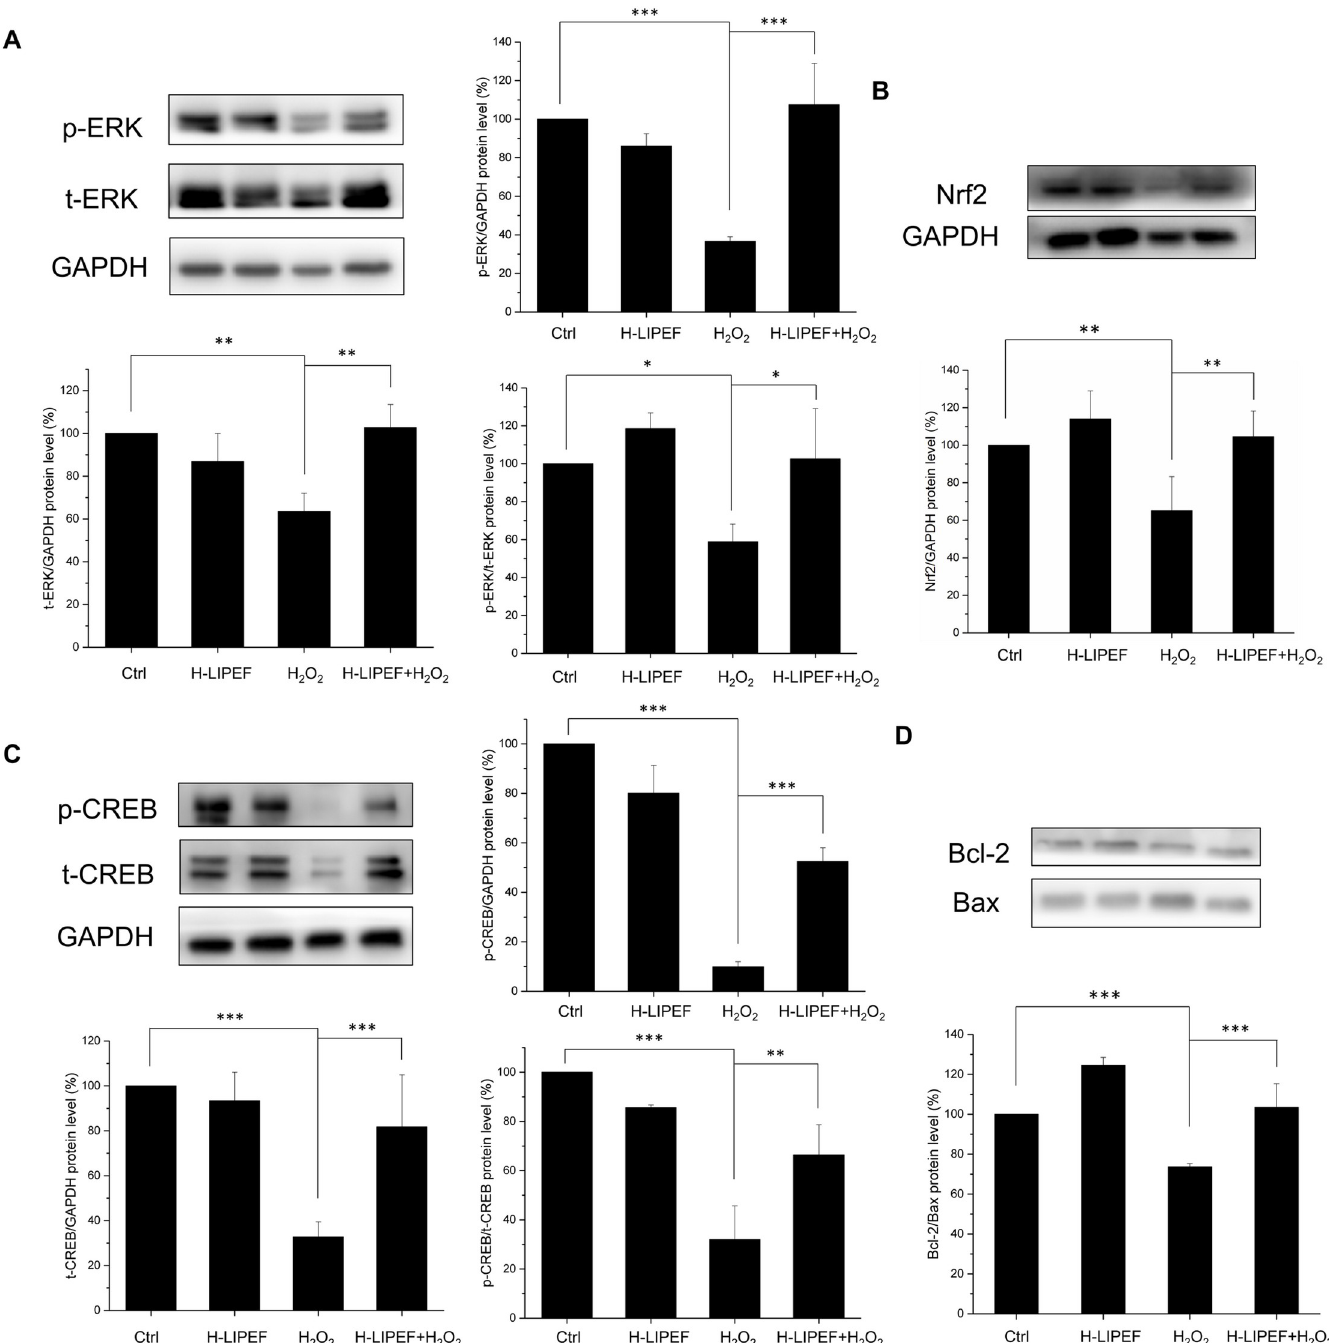
Fig 9. Effect of H-LIPEF on ERK/Nrf2 and ERK/CREB signalling pathways and related protein expressions. Western blot analysis of p-ERK and t-ERK (A), Nrf2 (B), p-CREB and t-CREB (C), Bcl-2 and Bax (D) protein expressions. The expression levels of p-ERK and p-CREB were normalized to t-ERK and t-CREB, respectively. The expression level of Nrf2 was normalized to GAPDH and each relative expression level was compared with control. Data represent the mean ± standard deviation (n = 3). Comparisons of the effect of H 2 O 2 and H-LIPEF on different protein levels were analyzed using two-way ANOVA with Tukey’s post hoc test ( ��� P < 0.001, �� P < 0.01 and � P <